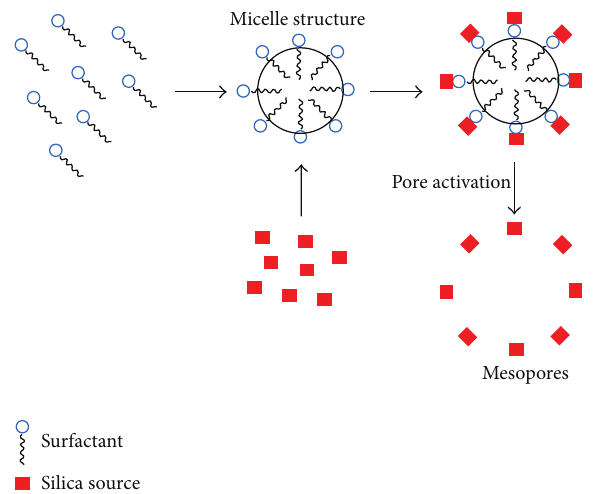
Figure 3: Mechanism for the synthesis of mesoporous silica in the presence of a cationic